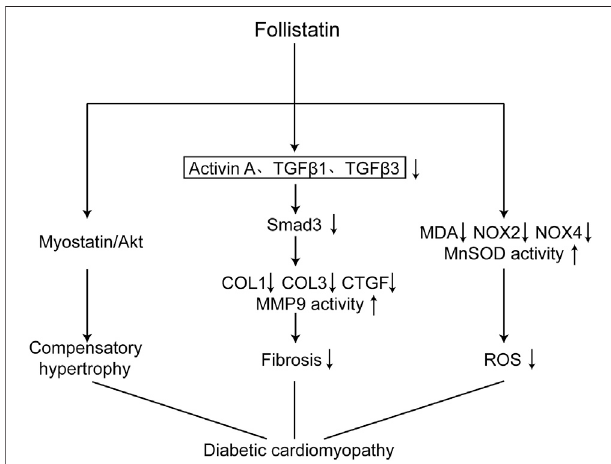
FIGURE 7 | Schematic diagram of the mechanism of FST in improving diabetic cardiomyopathy. Overexpression of FST in the heart attenuate diabetic cardiomyopathy through the following ways: causing compensatory hypertrophybytheMyostatin/Aktpathway,reducing fi brosisthroughthe TGF- β /Smad3 pathway, and decreasing oxidative stress by increasing the scavenging capacity of reactive oxygen species and reducing the production of reactive oxygen